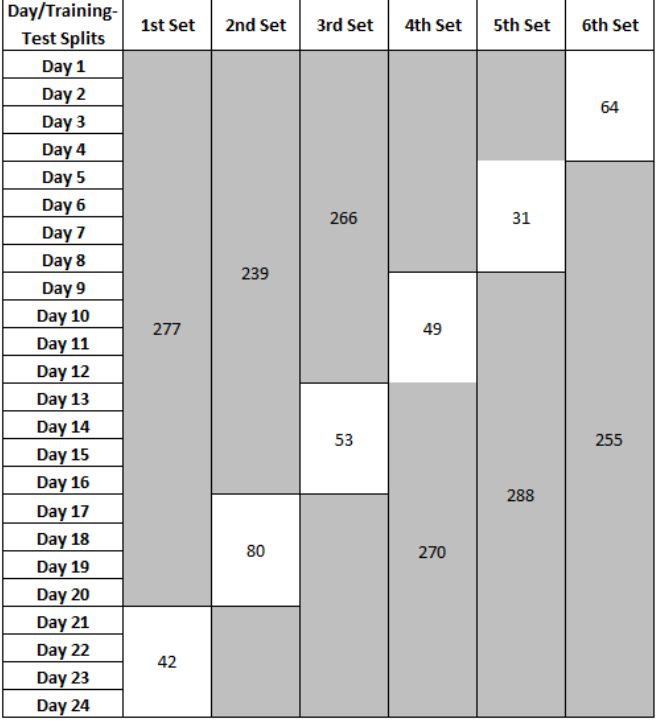
Figure 6. Leave-four days-out cross-validation on van Kasteren dataset. Training sets are shaded in grey and the unshaded are the testing sets. The values in each of the training-test splits refer to the number of activity examples in the training and test sets,